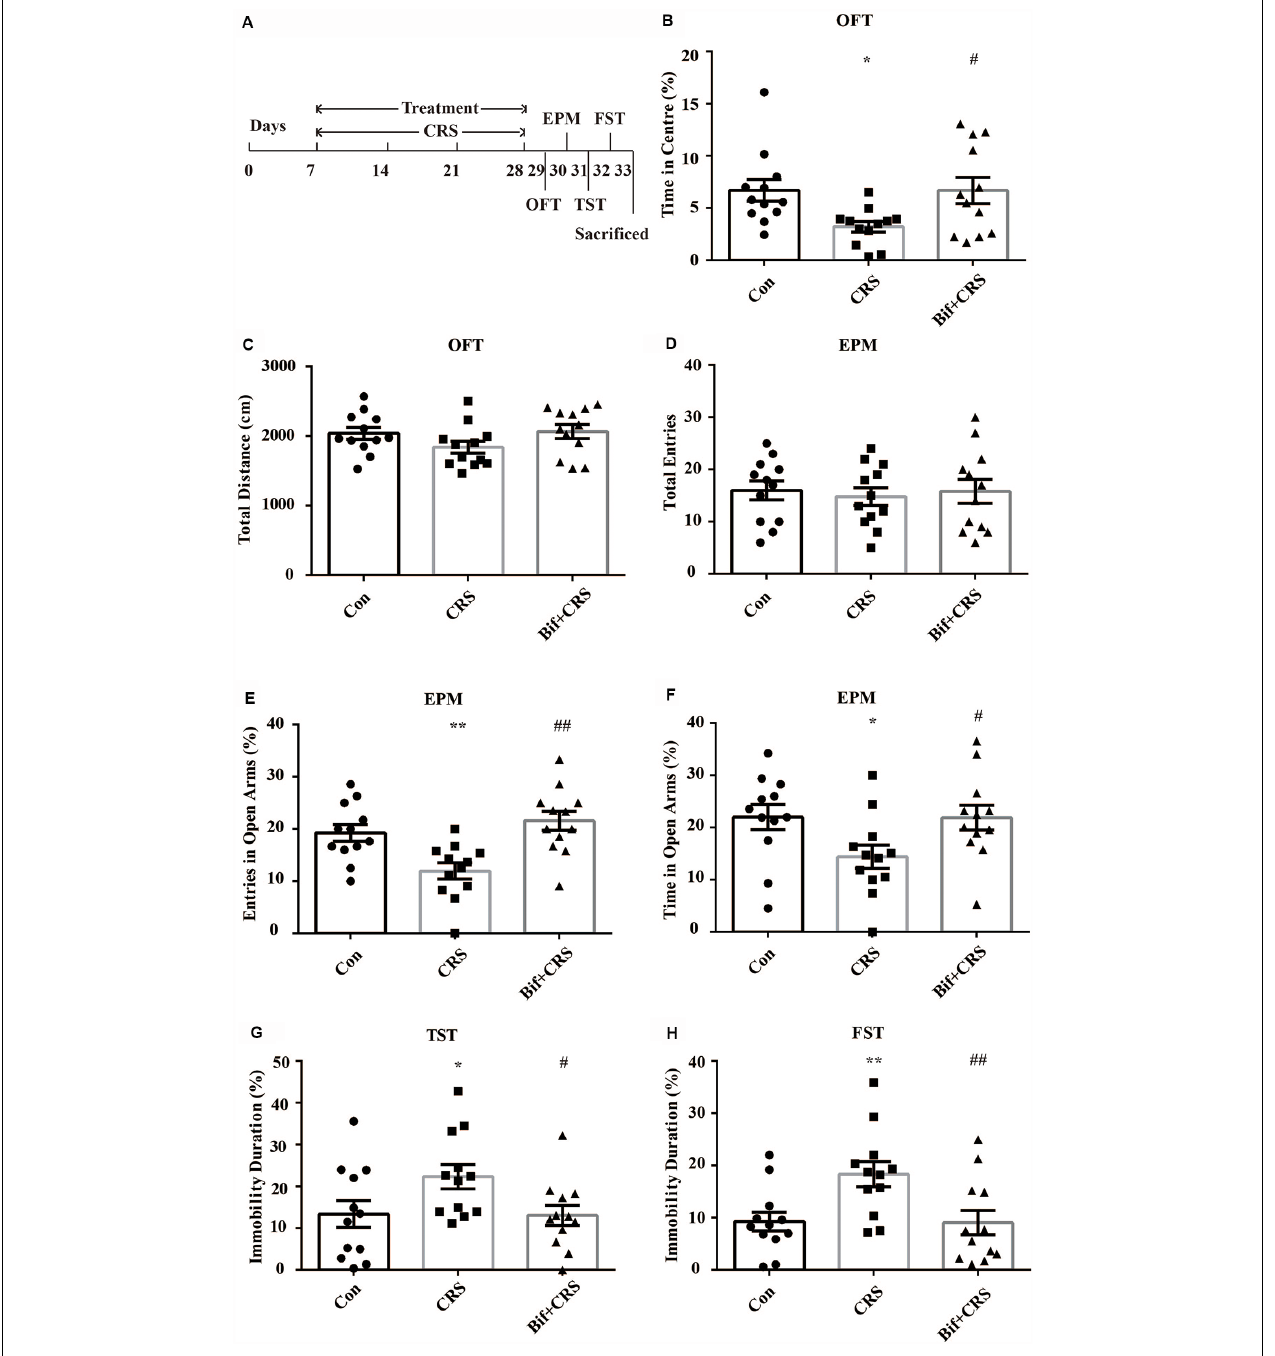
FIGURE 2 | Anxiolytic and antidepressant effects of B. adolescentis in chronic restraint stress (CRS) mice. The mice in the Con, CRS, and Bif+CRS groups were treated with 10 mL/kg distilled water, 10 mL/kg distilled water, and 0.25 × 10 9 CFU/kg B. adolescentis , respectively, by gavage for 21 days. (A) The schedules show the establishment of the CRS model, treatment, and behavioral tests. (B) The OFT showed that the time spent in the center was significantly decreased in the CRS group, and the change in the time spent in the center induced by CRS was reversed by B. adolescentis . (C) The OFT showed no significant difference among the three groups in the total distance traveled. (D) The EPM test showed no significant difference in the total number of entries induced by B. adolescentis . (E) The number of entries into the open arms of the EPM was significantly increased in the B. adolescentis group. (F) The time spent in the open arms of the EPM was significantly increased in the B. adolescentis group. (G) The TST showed that the immobility duration was significantly increased in the CRS group; the change in the immobility duration induced by CRS was reversed by B. adolescentis . (H) The FST showed that the immobility duration was significantly increased in the CRS group;